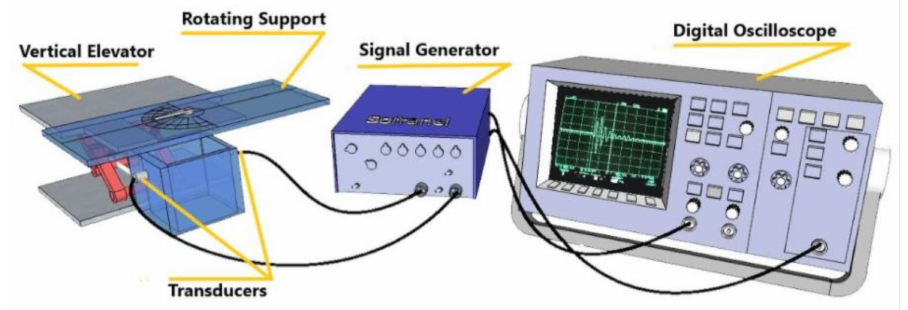
Figure 2. Experimental